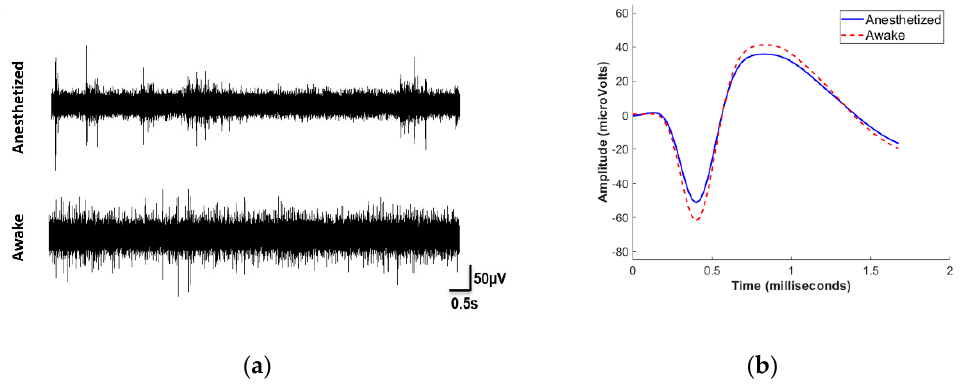
Figure 2. Neurophysiological data acquisition. ( a ) Exemplary single-unit recordings of an animal in anesthetized and awake state, respectively, are shown here. ( b ) Representative mean waveform of a unit under anesthesia and when awake.